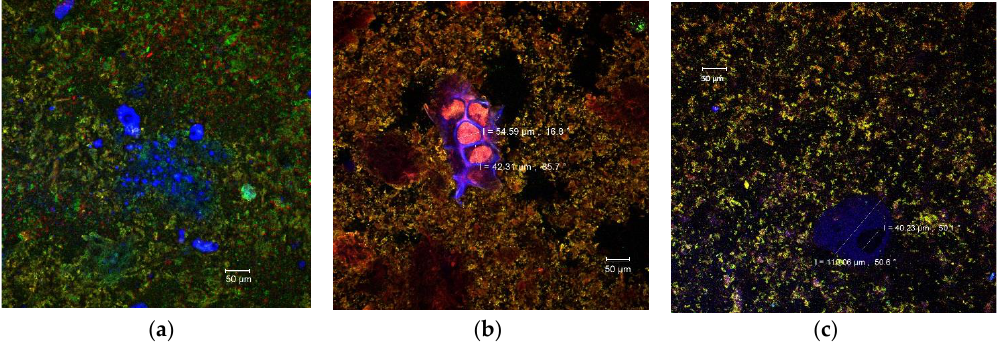
Figure 2. Confocal laser scanning microscopy images of the pastry cream samples: Control ( a ), PC-5 ( b ), and PC-10 ( c